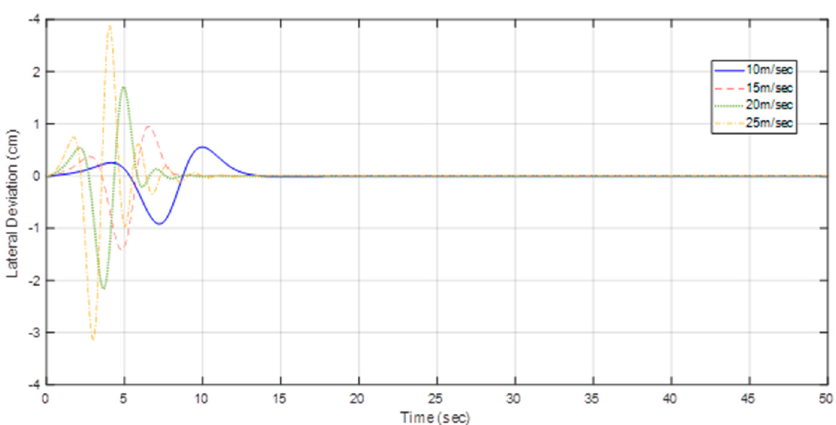
Figure 6. Performance analysis of the fuzzy-PD controller at various longitudinal velocities.